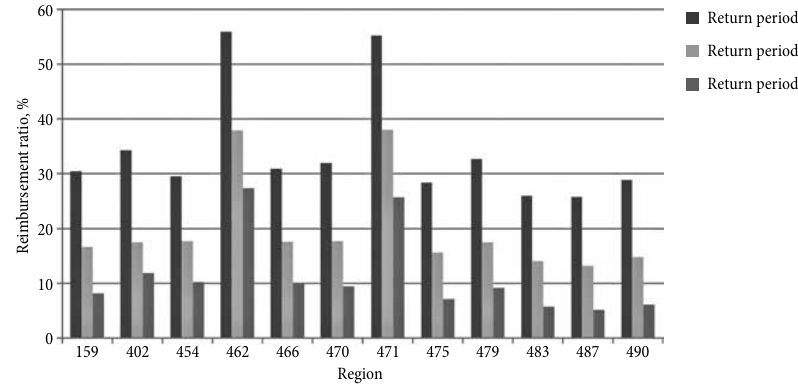
Fig. 8. Proportion of buildings in a state of complete